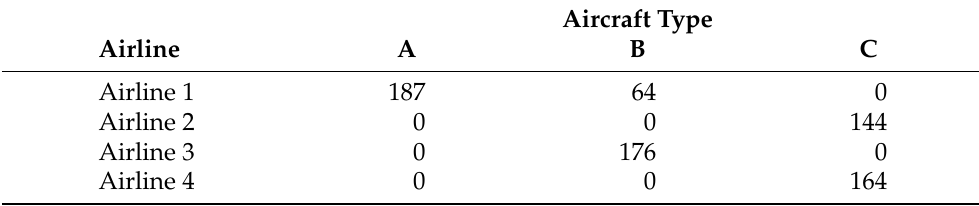
Table 4. Contingency table of airline vs. aircraft type for the Madrid–London Gatwick OD